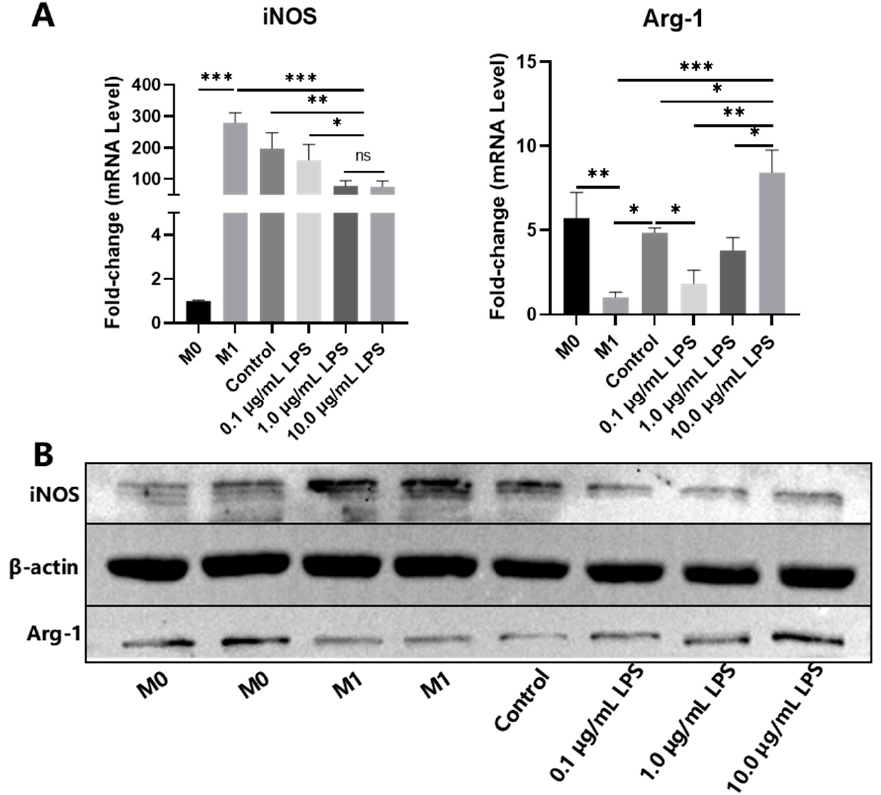
Figure 3. Effect of CM derived from LPS-pretreated PDLSCs on macrophage polarization. ( A ) qRT- PCR: iNOS and Arg-1 mRNA expression in M1 macrophages after culturing with CM derived from 0 (Control), 0.1, 1.0 and 10.0 µg/mL LPS-pretreated PDLSCs. ( B ) Western blot: iNOS and Arg-1 protein expression in M1 macrophages after culturing with CM derived from 0 (Control), 0.1, 1.0 and 10.0 µg/mL LPS-pretreated PDLSCs. * p < 0.05; ** p < 0.01; *** p < 0.001.